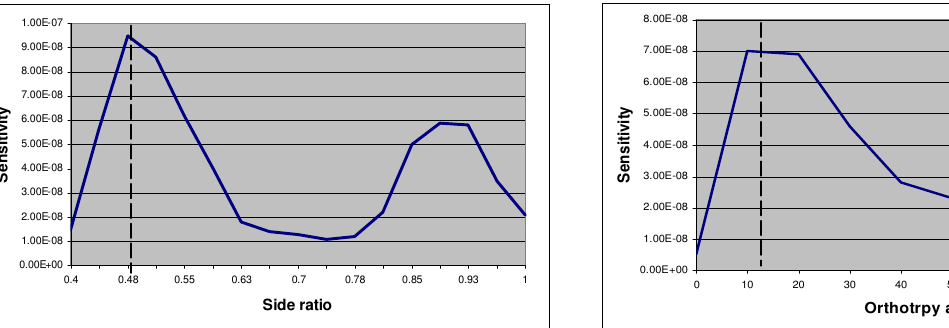
Fig 5. Approximated values of sensitivity of in-plane Poisson’s ratio to the side ratio Table 5. Identified material properties of carbon-epoxy specimen (square specimen)